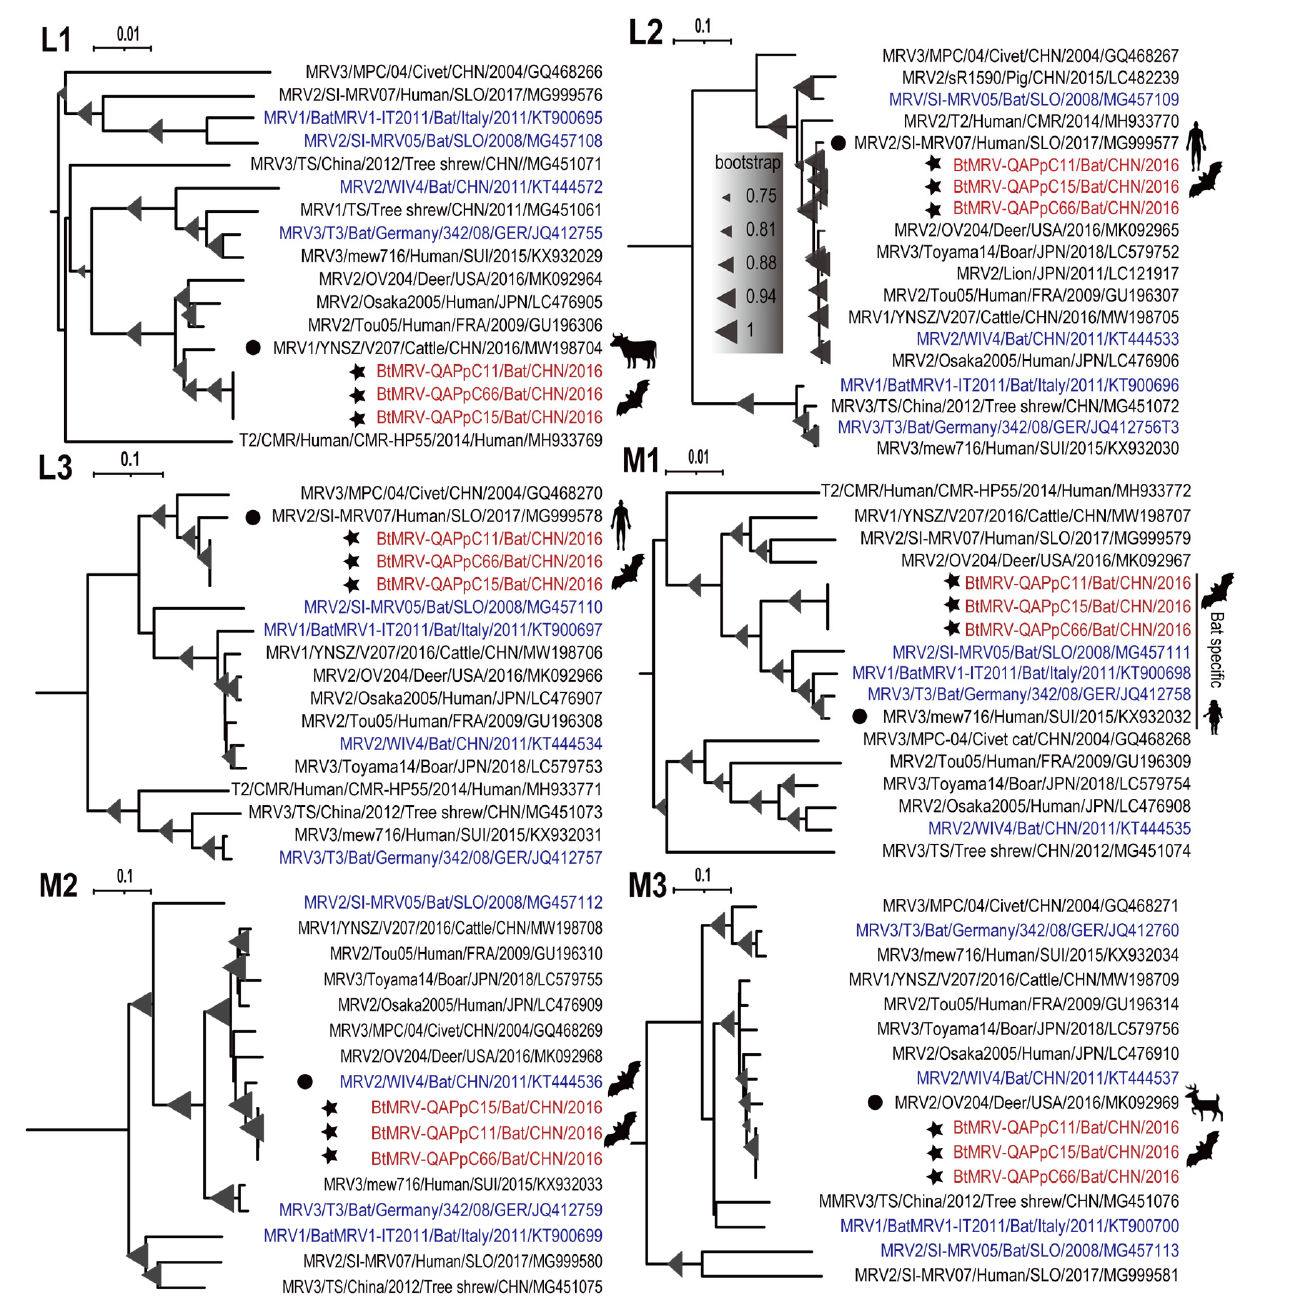
Figure 3. Phylogenetic analyses of the ( L1 – M3 ) segments based on nt sequences. The phylogenetic reconstruction was implemented using the maximum likelihood method and the best-fit model with 1000 bootstrap replicates. Each MRV is identified with its serotype, name, host, country, year, and GenBank accession number. Bootstrap value greater than 75 is shown on the node as a triangle with its size indicating the value (shown in panel L2). The three bat MRV isolates in this study are headed with filled stars, and their closest genetic neighbors are indicated with filled circles. The scale bar indicates the genetic distance. The animal cartoons indicate the hosts of the viruses they are next to, and their meanings are shown in Figure 5.